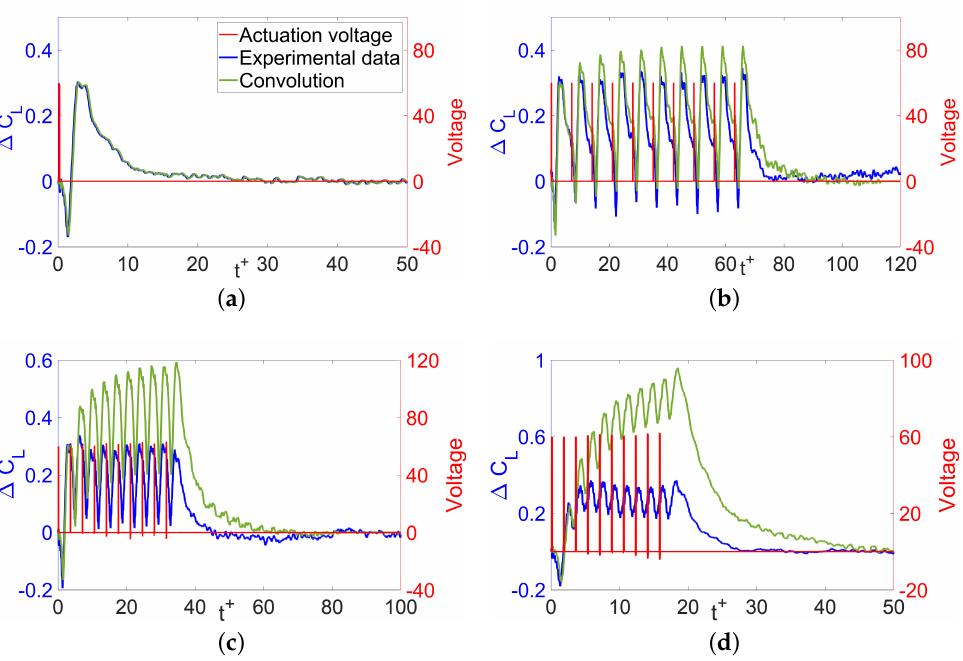
Figure 4. Lift response to burst-actuation at α = 20 ◦ . The red lines show the voltage to the actuators, the blue line is the measured ∆ C L and the green line is the ∆ C L predicted by the convolution model. ( a ) Single burst at t=0, ( b ) 10 repeated bursts at the optimal T = 1.75 tconv , ( c ) 10 repeating bursts at T = 3.5 t conv and ( d ) 10 repeating bursts at T = 7 t conv